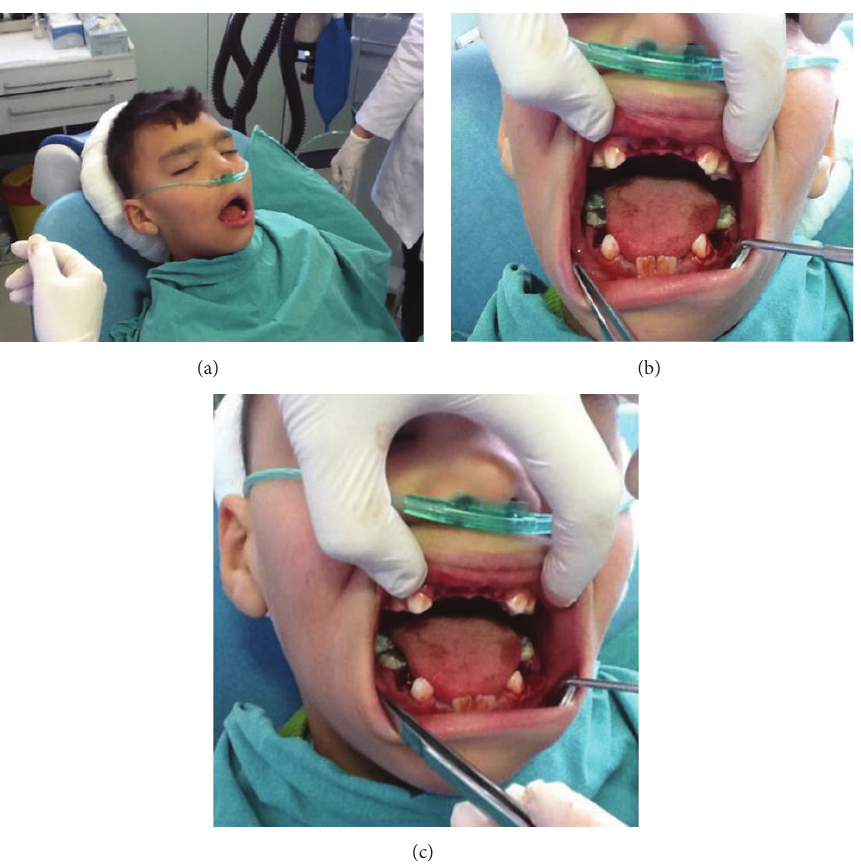
Figure 3: Considering the patient’s mental retardation and lack of cooperation on dental chair, it was decided to make the dental treatments under moderate sedation.